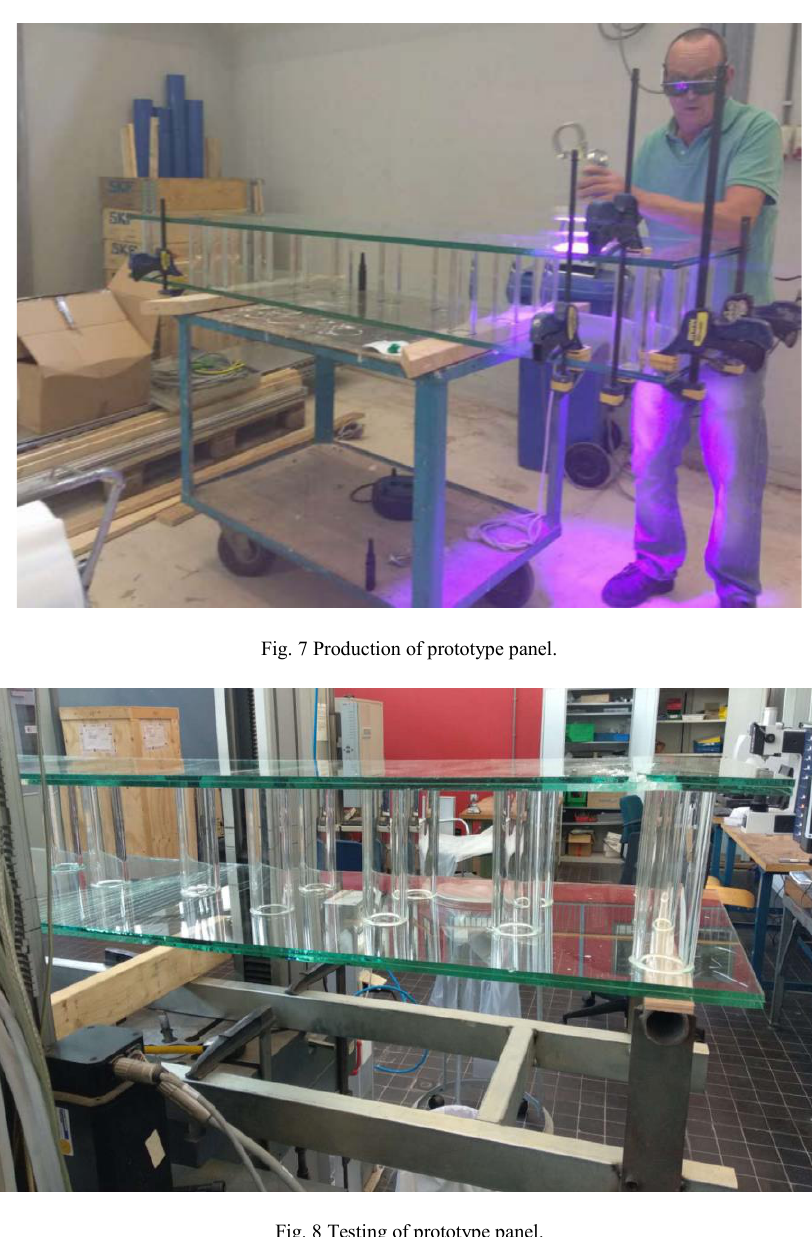
Fig. 8 Testing of prototype panel.